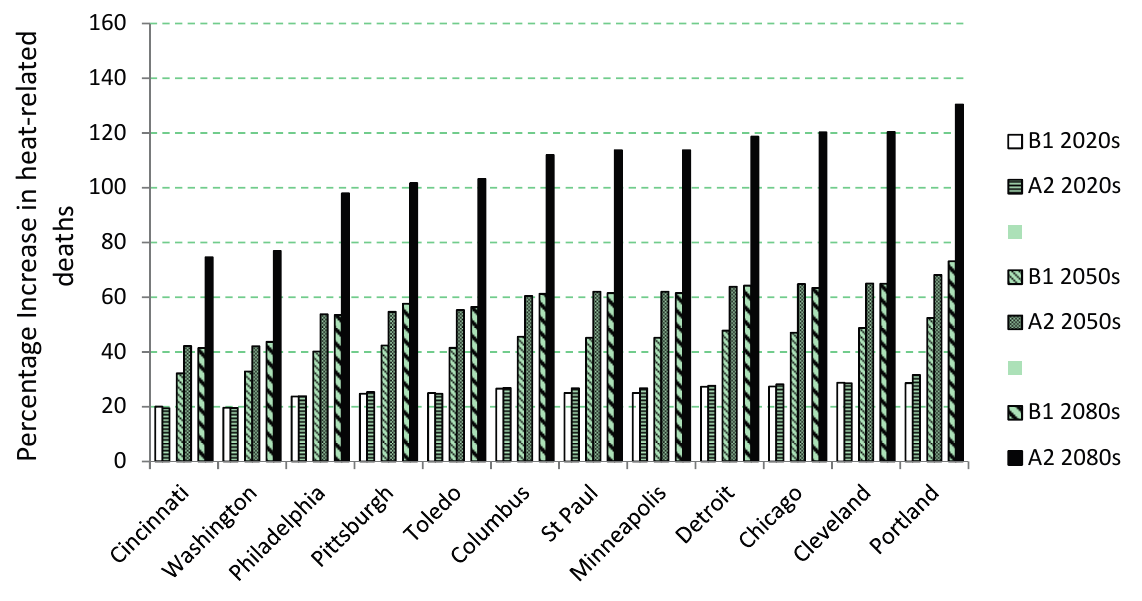
Figure 2. Percentage increase in heat-related deaths during 2020s, 2050s and 2080s compared to the 1980s baseline period for the twelve cities. Calculated across the 16 global climate models (GCMs) used in this study and displayed separately for the low emissions (B1) and high emissions (A2)